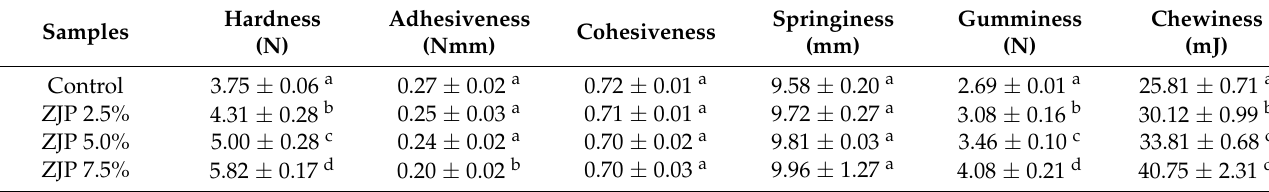
Table 3. Effect of ZJP enrichment on the textural profile of pizza base variants.